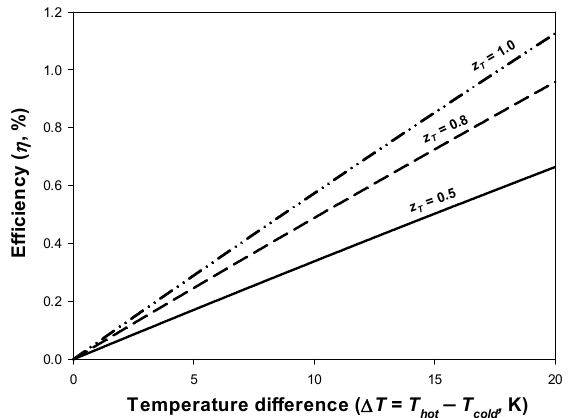
Figure 2. Efficiencies calculated from (4) for different figures of merit z T versus the temperature difference between the hot and cold sides of the TEG, assuming T cold = 20 °C and T hot = T cold + ∆ T .